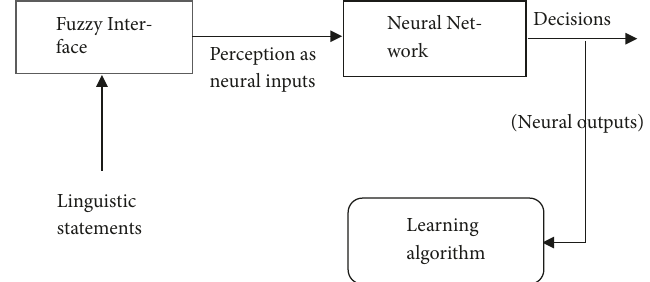
Figure 2: The general structure of Adaptive Neuro-Fuzzy Inference System.